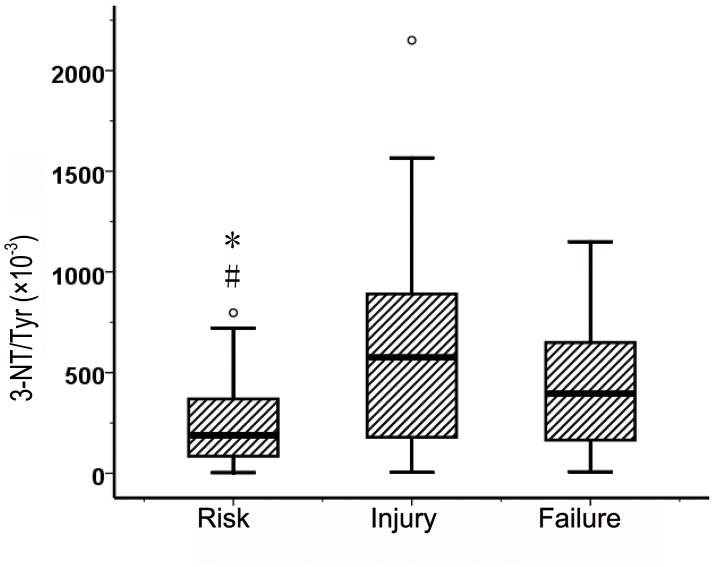
3-NT/Tyr in 158 patients with AKI stratified by RIFLE stages.* t test p = 0.002, AKI patients in risk stage compared to in injury stage; # t test p = 0.007, AKI patients in risk stage compared to in failure stage.